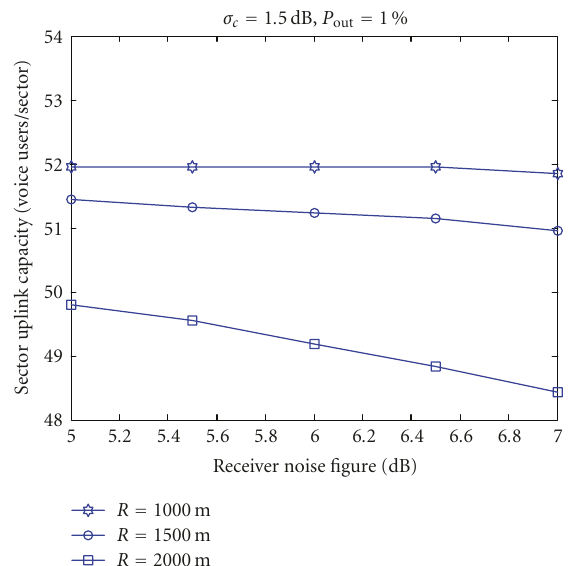
Figure 14: E ff ect of the base station receiver noise figure on the sector uplink